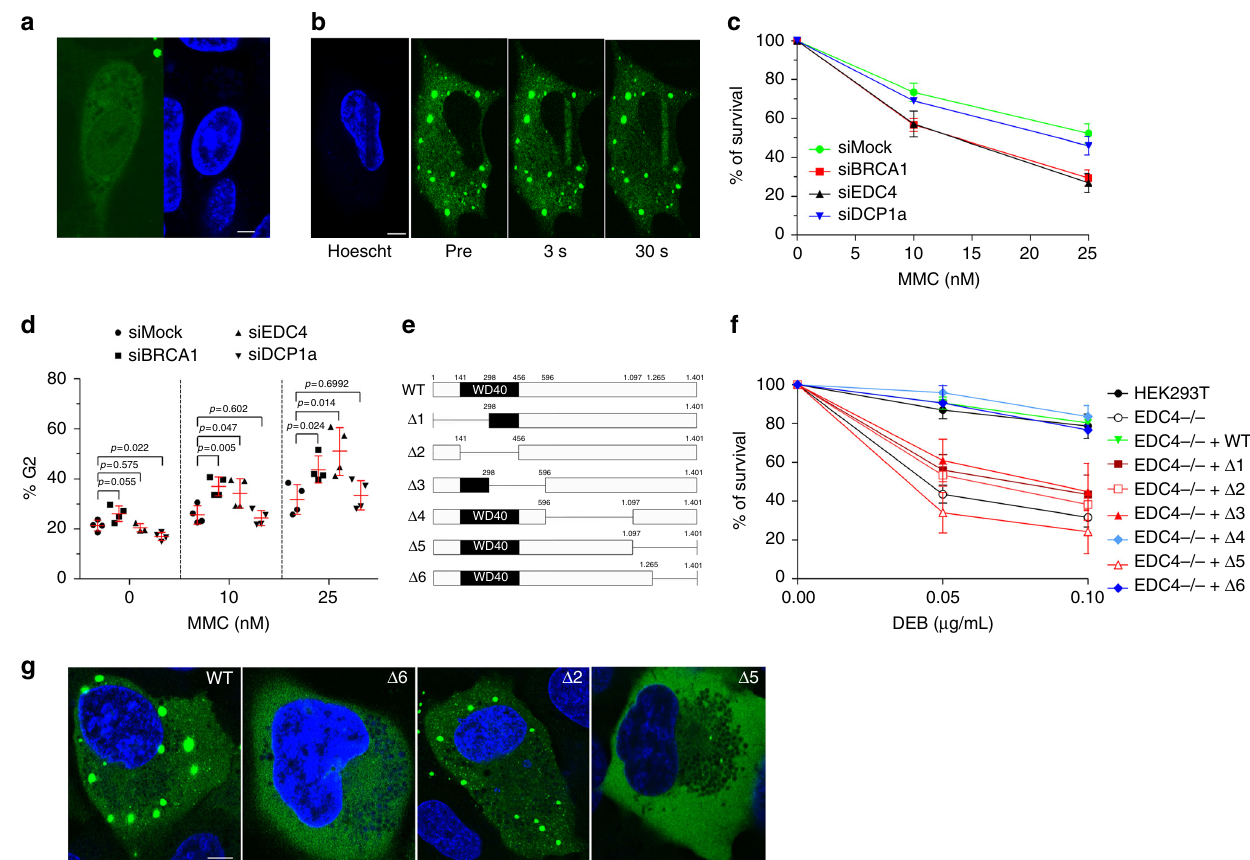
Fig. 3 EDC4 is required for genome maintenance. a Confocal image of U2OS cells expressing GFP-tagged wild-type EDC4 showing an example of cell with nuclear localization of EDC4 in the absence of DNA damage. Scale bar represents 10 µ m. b U2OS cells expressing GFP-EDC4 were subjected to laser micro-irradiation (see Methods). GFP-EDC4 images were taken before and after laser micro-irradiation by confocal microscopy. Scale bar represents 10 µ m. c , d DCP1a is not required for the survival of HeLa cells exposed to MMC or for the G2/M blockade. Data shown represent results from four combined independent experiments. Error bars indicate mean ± s.d. Means were statistically compared using the two-tailed Student ’ s t test. Statistical analysis comparing the means of the Mock-treated vs. gene-speci fi c siRNA-treated samples for the sensitivity to MMC were performed with the following p values: siBRCA1 (10 nM, p = 0.0122; 25 nM, p = 0.0005), siEDC4 (10 nM, p = 0.0115; 25 nM, p = 0.0012), and siDCP1a (10 nM, p = 0.1574; 25 nM, p = 0.1862). e Diagram showing the regions of EDC4 deleted for functional studies. f Survival after DEB treatment of the six EDC4 deletion mutants generated in HEK cells. Data shown represent results from at least two combined independent experiments. Error bars indicate mean ± s.d. Means were statistically compared using the two-tailed Student ’ s t test. No statistically signi fi cant difference was observed between WT, Δ 4 ( p = 0.233; p = 0.516), Δ 6 ( p = 0.852; p = 0.455), and corrected cells ( p = 0.8832; p = 0.4646), while the rest of the mutants were found statistically different compared with the WT cell line (EDC4 − / − , p = 0.0013 and p = 0.0027; Δ 1, p = 0.001 and p = 0.002; Δ 2, p = 0.0009 and p = 0.0017; Δ 3, p = 0.0542 and p = 0.0032; Δ 5, p = 0.0001 and p < 0.0001). g Representative fl uorescence images of U2OS cells expressing GFP-tagged WT EDC4 and deletion forms of GFP-EDC4 to demonstrate differences in P-body formation (cytoplasmic green aggregates). Scale bar represents 10 µ